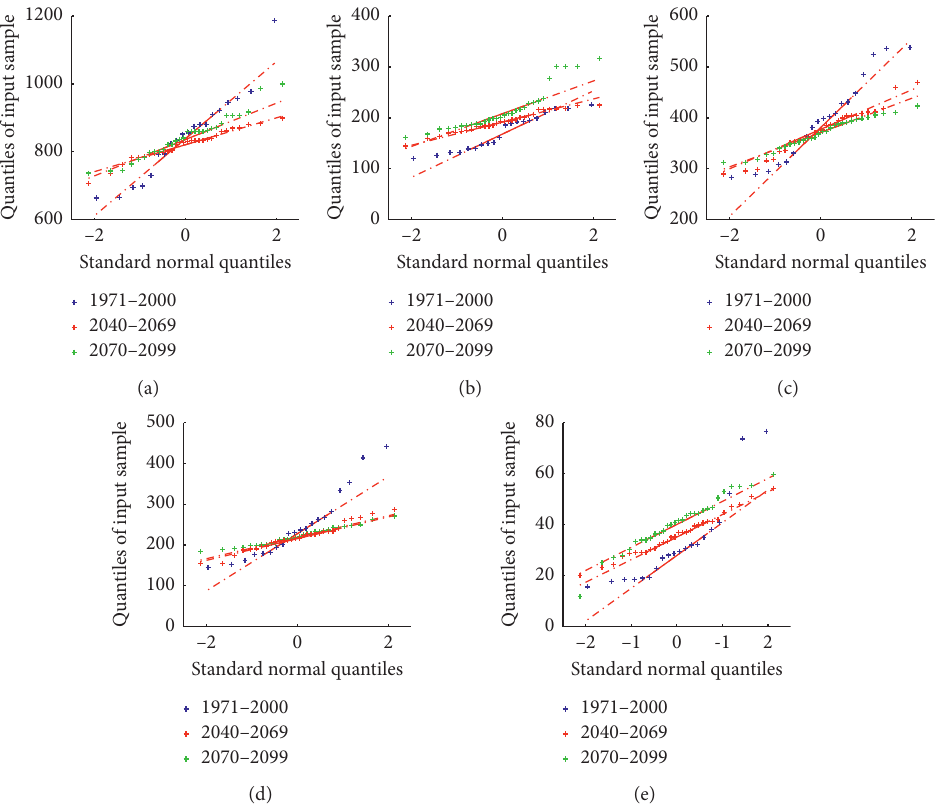
Figure 12: Quantile-quantile plots of historical and projected precipitation under RCP45 scenario: (a) year, (b) spring, (c) summer, (d) autumn, and (e) winter,